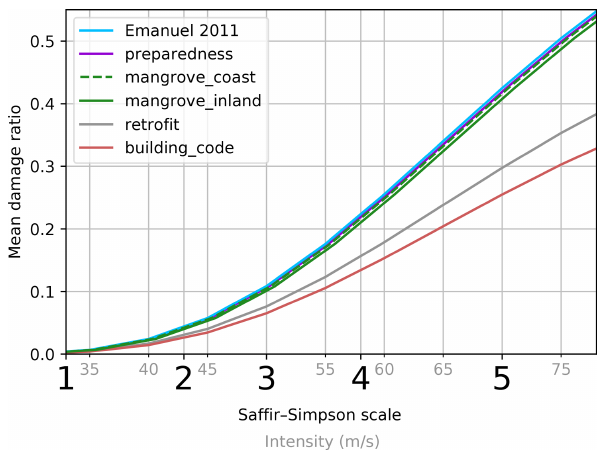
Figure 2. Impact functions used in the definition of adaptation op- tions. Emanuel 2011 refers to the impact function used in the risk assessment, following Emanuel (2011), and the Saffir–Simpson hur- ricane wind scale is shown as a reference (Schott et al., 2019). pre- paredness is the impact function obtained once the behavioral mea- sure named preparedness is implemented. Mangrove reforestation generates the mangrove_coast impact function at a distance of up to 500m from the coast and the mangrove_inland impact function on the rest of the island. retrofit and building_code show an impact re- duction of 30% and 40%, respectively, at every wind intensity with respect to Emanuel 2011 . See Aznar-Siguan and Bresch (2019b) for details about the mean damage ratio